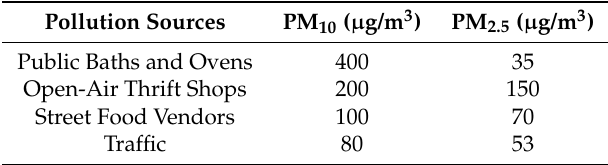
Table 3. Pollution sources and pollution concentrations measured in their